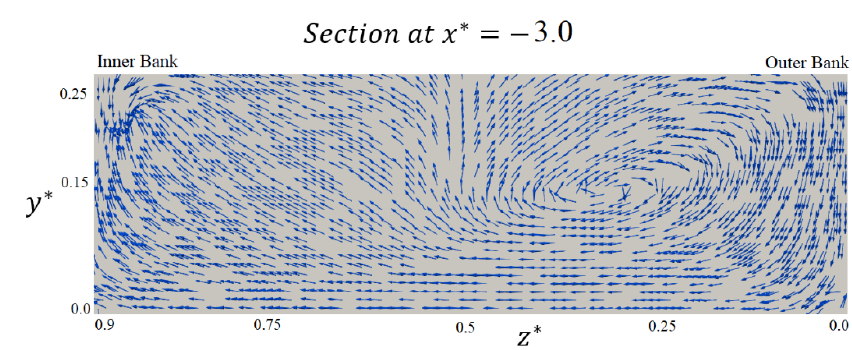
Figure 21. The vectors of velocity at section x* = − 3.0 (Realizable k- ε ).